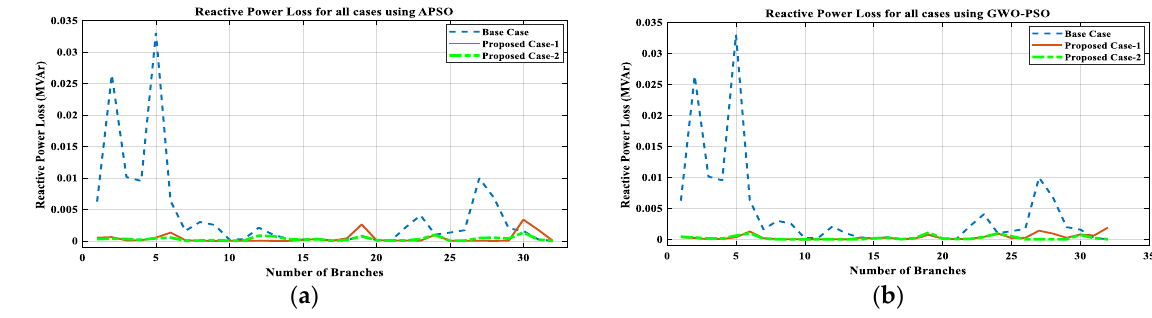
Figure 13. C umulative representation of active and reactive power loss for all cases of 33-bus RDN; ( a ) APSO, ( b ) GWO-PSO.